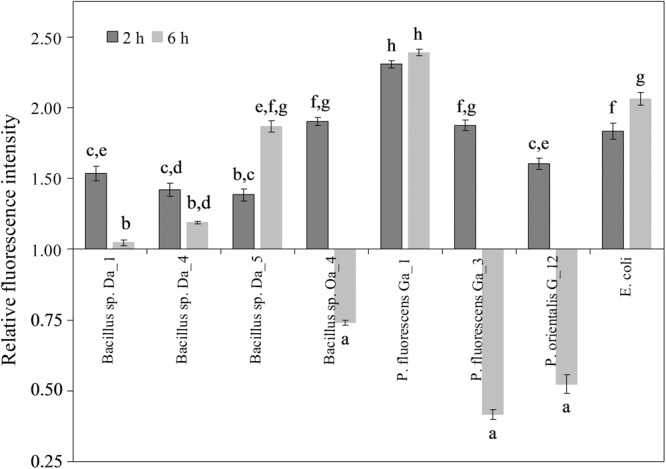
Effect of endophytic bacteria on the accumulation of ROS/RNS in apple cells. Apple cell suspension was inoculated with each strain at the final concentration of ∼107 cfu/ml and observations was made after 2 and 6 h. Data are presented as mean and SEM of at least three repeats from three independent experiments. Means followed by the same letter are not significantly different (p < 0.05).